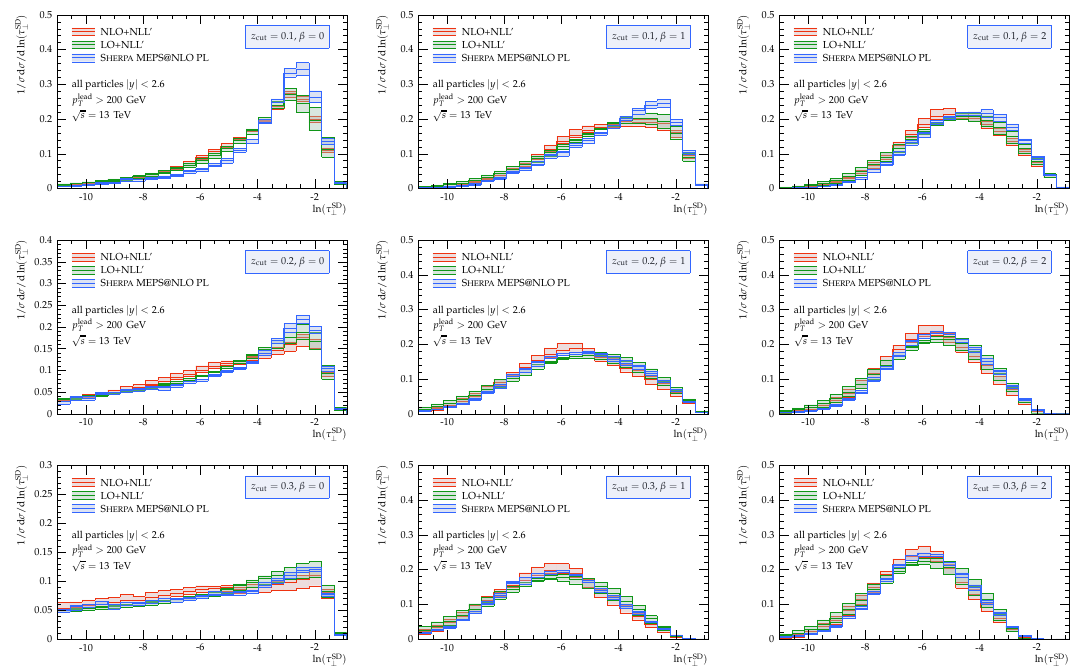
Figure 10 . NLO + NLL 0 and LO + NLL 0 predictions for groomed transverse thrust for β ∈ { 0 , 1 , 2 } (columns) and z cut ∈ { 0 . 1 , 0 . 2 , 0 . 3 } (rows) for the p T, min = 200 GeV event selection in comparison to parton-level MEPS @ NLO results from S HERPA